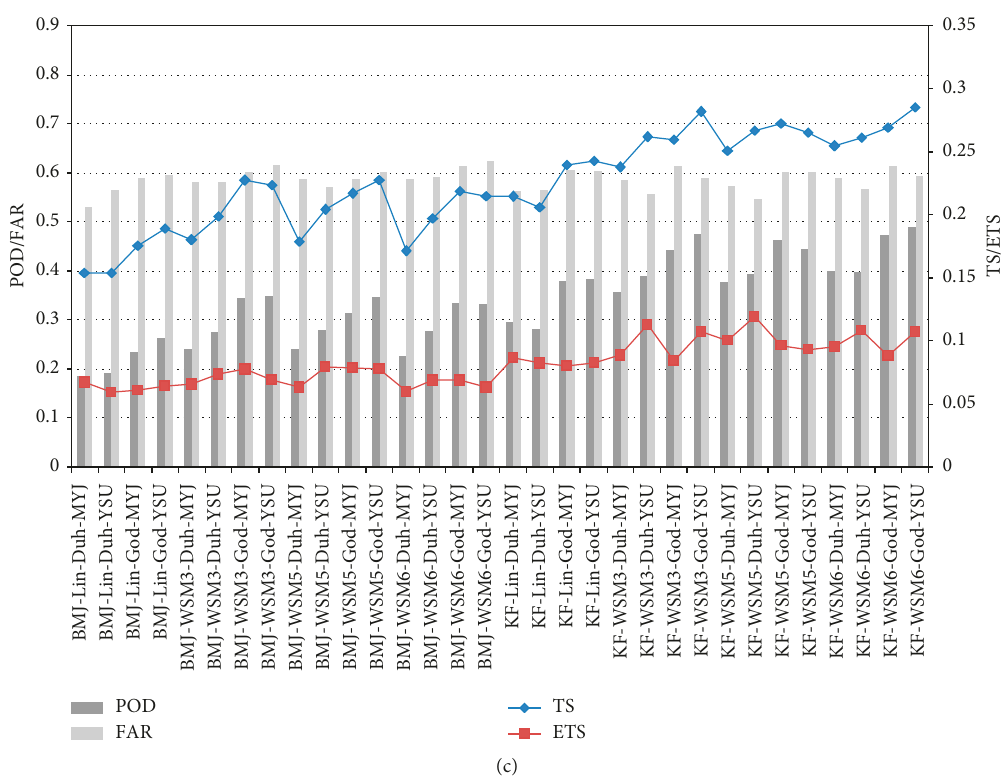
Figure 5: Skill scores calculated for northern Vietnam for daily accumulation thresholds over 25mm for (a) 24h, (b) 48 h, and (c) 72h forecast ranges. The dark grey bar is for POD, light grey bar is for FAR, blue dotted line is for TS, and red dotted line is for ETS. In each chart, the left vertical axis (0–0.9) is for POD and FAR, while the right vertical axis (0–0.35) is for TS and ETS values. The number of samples is 8064 for an individual